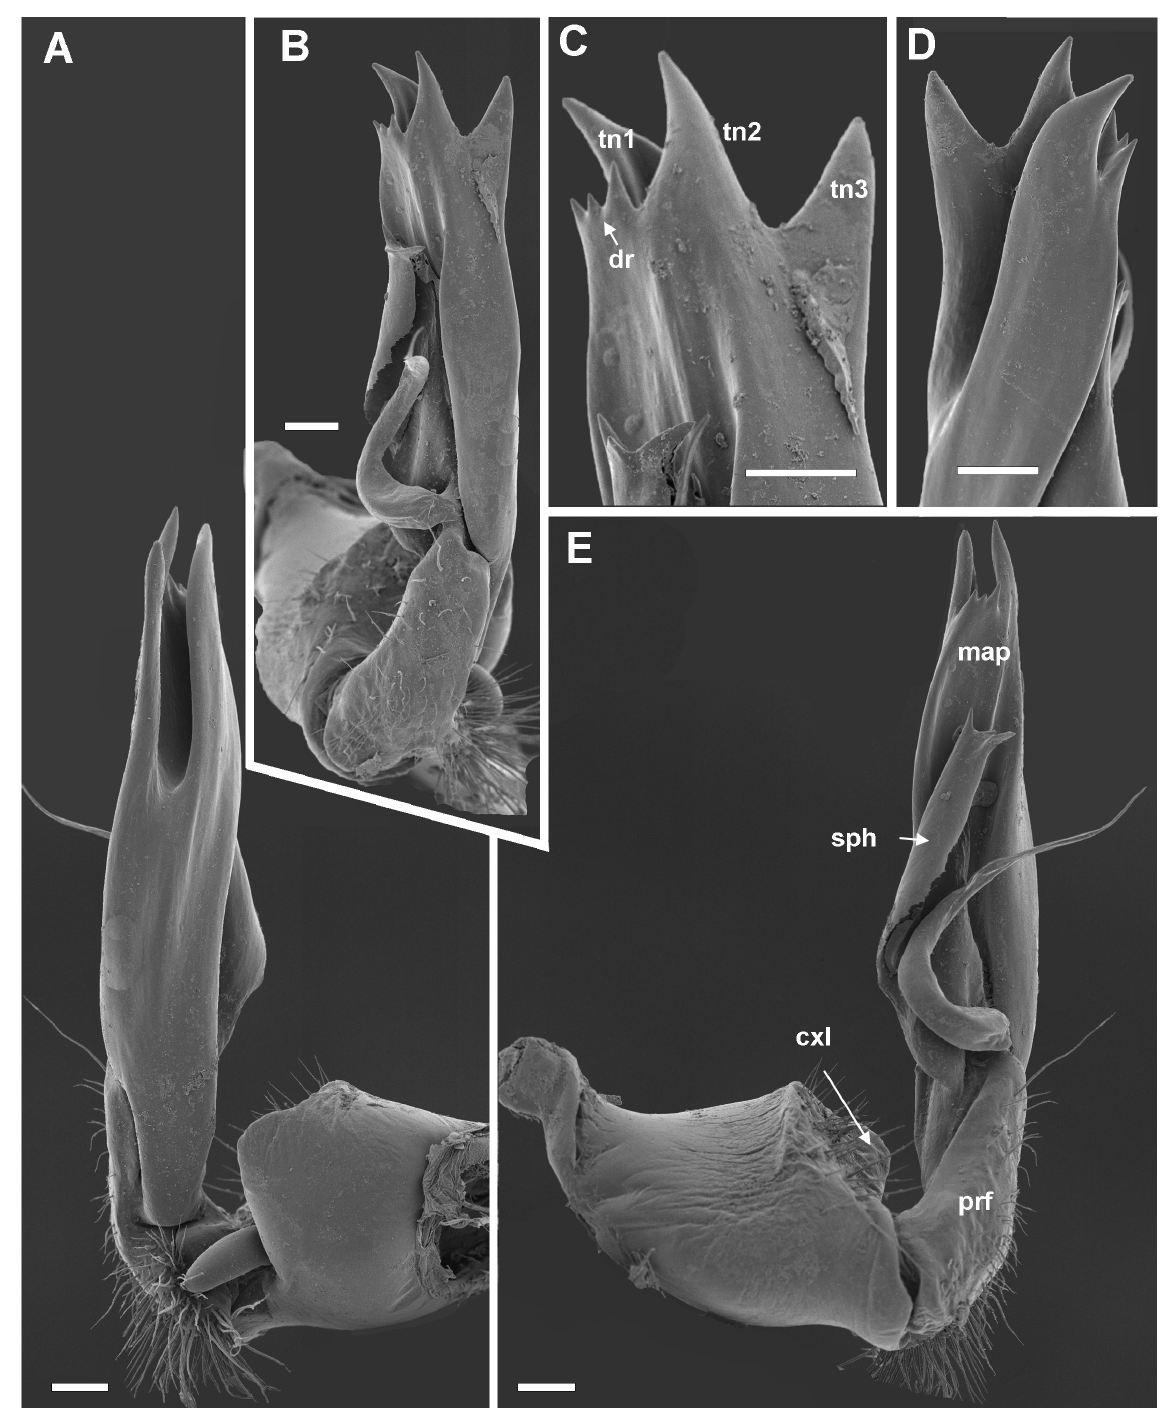
Fig. 27. Eviulisoma sternale sp. nov., holoype, right gonopod. A . Mesal view. B . Ventral view. C . Tip of mesal acropodital process ( map ), ventral view. D . As C, dorsal view. E . Lateral view. Abbreviations: cxl = coxal lobe; dr = dentate ridge; map = mesal acropodital process; prf = prefemoral part; sph = solenophore; tn1 , tn2 , tn3 = apical tines of process map . Scale bars: 0.1